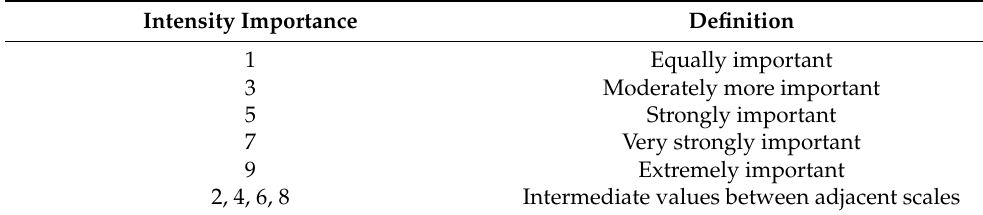
Table 2. Saaty’s nine-point scale of pairwise comparison [24].